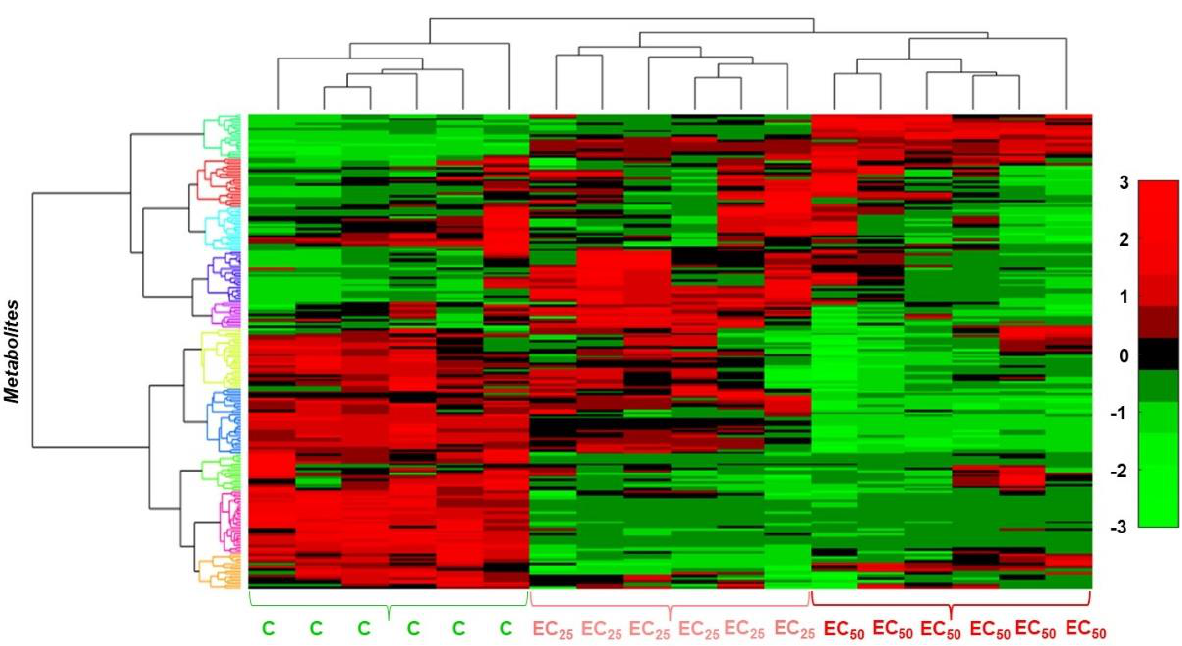
Figure 4. Effect of the Bacillus sp. PTA13 lipopeptide extract (EC 25 = 156 µ g · mL − 1 and EC 50 = 419 µ g · mL − 1 ) on the GC/EI/MS metabolite profiles of Lemna minor L. 72 h following treat- ments, visualized using two-dimensional cluster heat map. Hierarchical cluster analysis (HCA) was performed applying the Ward’s linkage method. The columns correspond to the treatments and the rows to metabolite features. Cells are color-coded according to the relative content of the metabolite features ranging from − 3 (light green) to 3 (light red), designating low to high values, respectively. In total, fifteen biological replications of two plants each were performed per treatment, every three of which were pooled to provide a pooled sample. Five pooled samples and one quality control were analyzed per treatment (C;